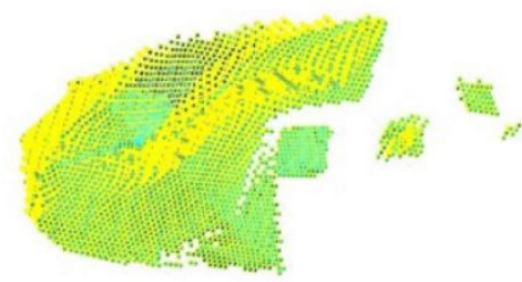
Figure 7: Grade model of sulfur ore after coloring by attribute